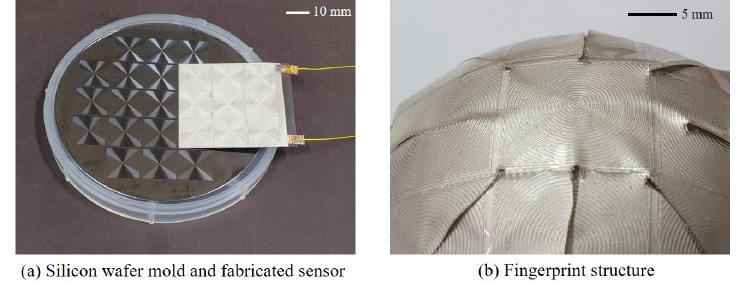
Figure 2. Wafer mold and fabricated